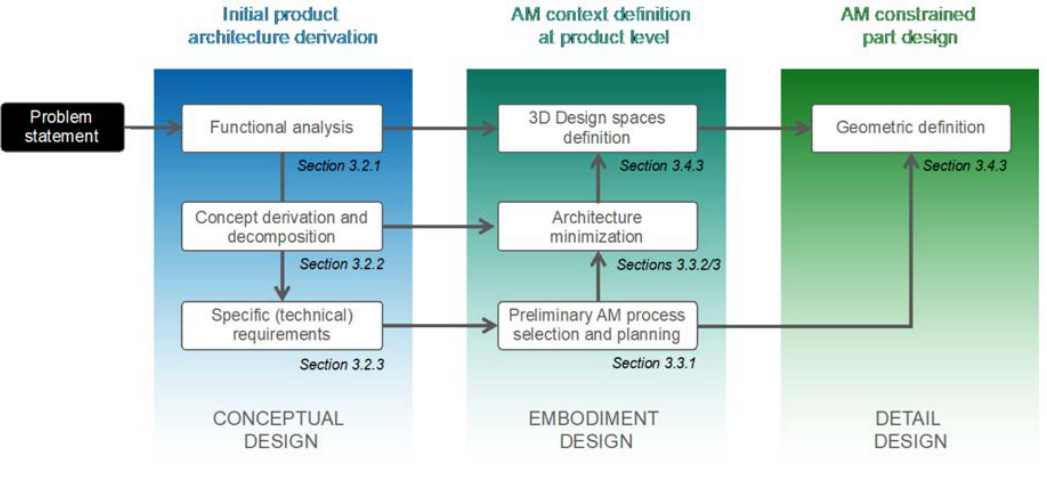
Figure 1. Flowchart of the assembly-oriented design framework for AM (blue boxes relates steps, green ones represents input/output